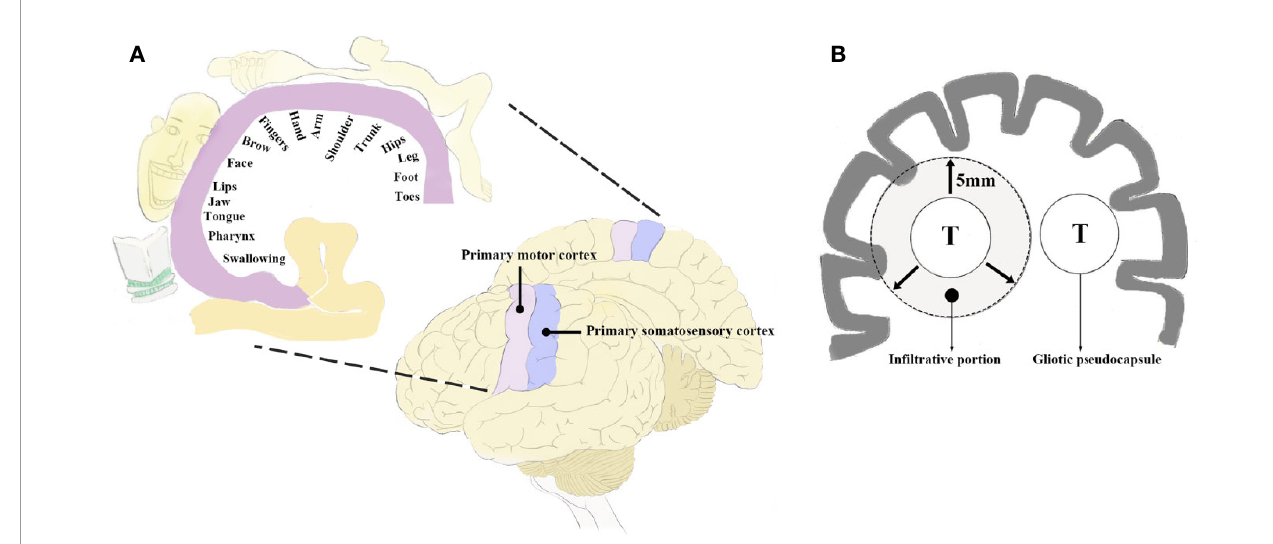
FIGURE 1 | (A) Diagram of the perirolandic region illustrating the primary motor cortex, primary somatosensory cortex, and the classic homunculus. The areas of sensorimotor cortex supporting motricity and sensitivity are inverted and disproportionate based on the sensorimotor patterns ( fi ne or gross) as depicted in the coronal planes. (B) Schematic illustration exhibiting the in fi ltrative growth pattern of BM which may extend to 5 mm beyond the gliotic pseudocapsule. T, tumor; BM, brain